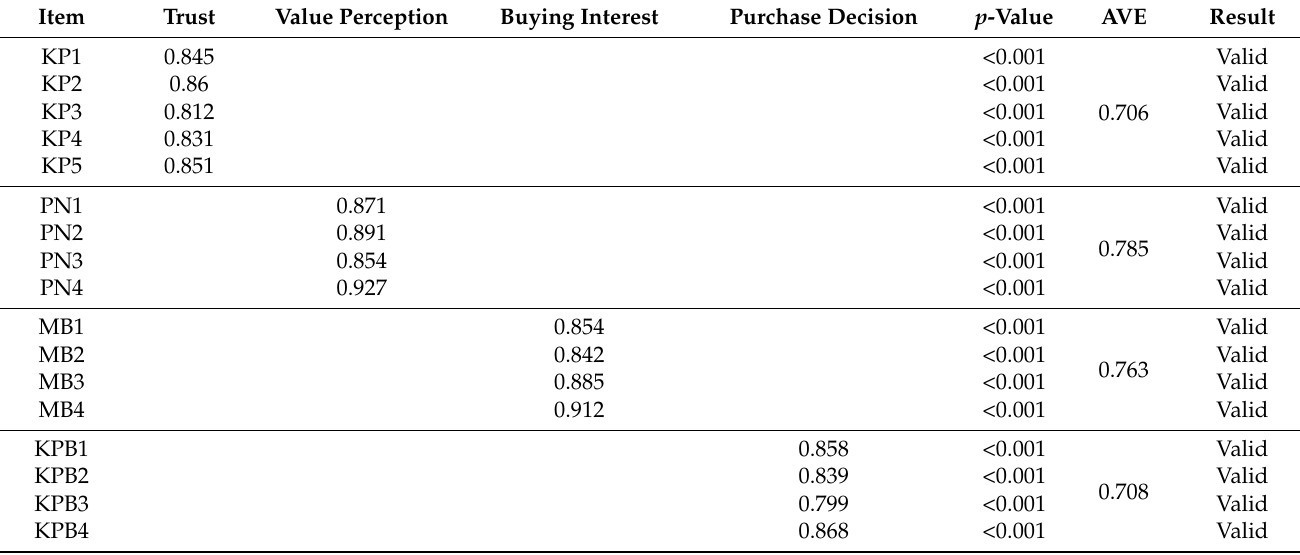
Table 1. Convergent Validity and AVE.